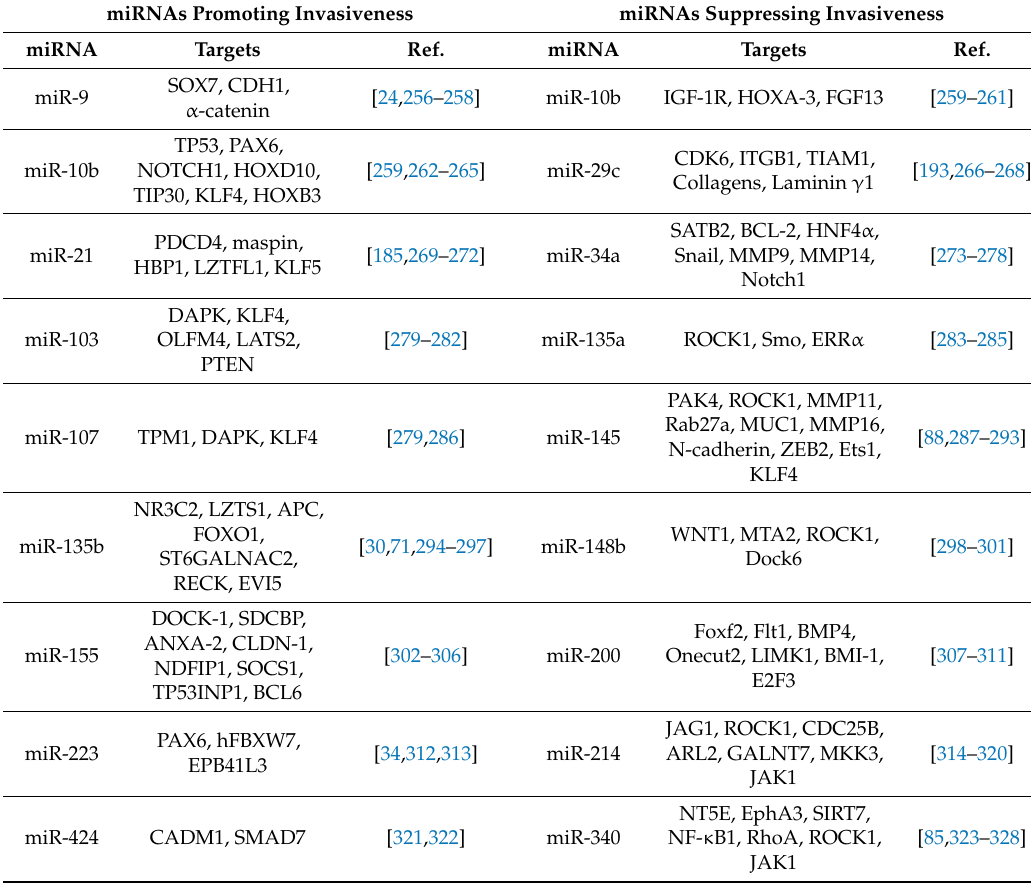
Table 5. MiRNAs regulating cancer cell invasiveness and their direct